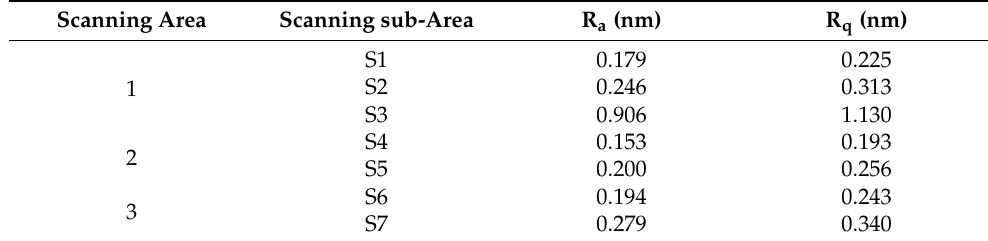
Table 1. Results of the AFM scanning of the silicon resonator profile’s surface.